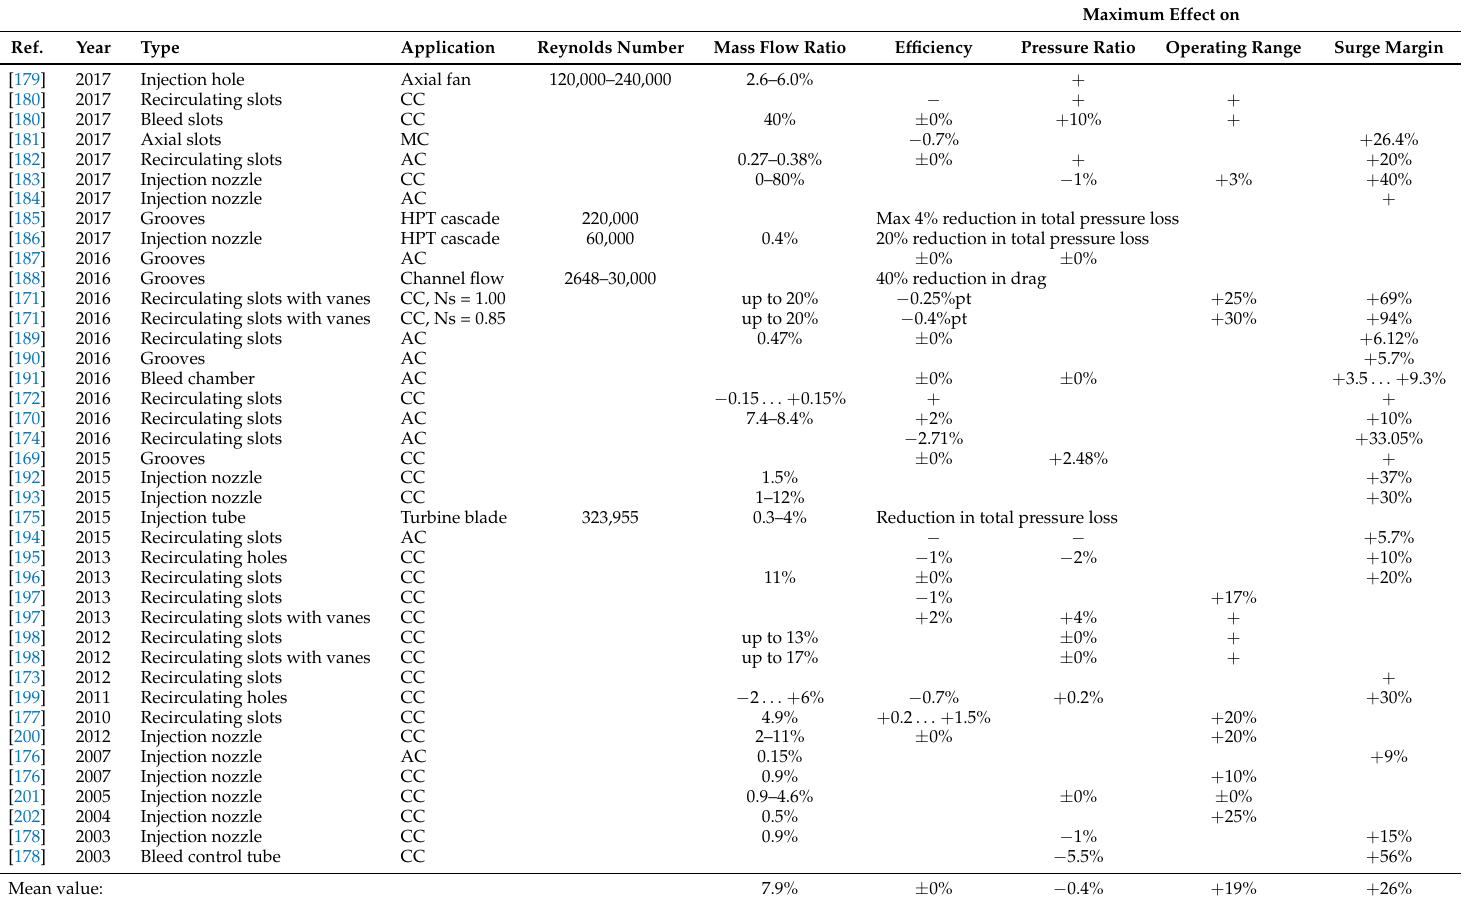
Table 10. Representative summary of active and passive casing